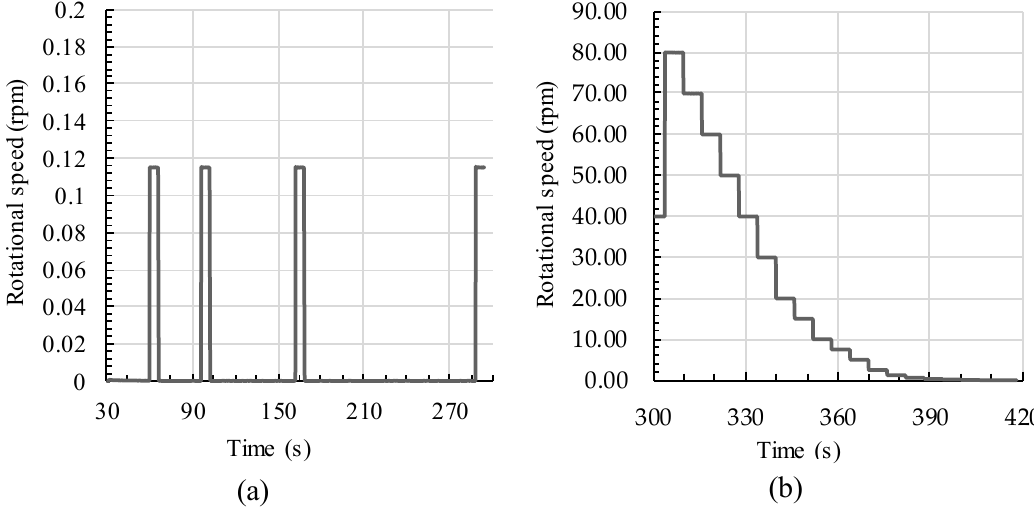
Figure 3. Shear profile for rheological measurements: ( a ) Static profile for thixotropy investigation and ( b ) dynamic profile with a stepwise decreasing rotational speed.